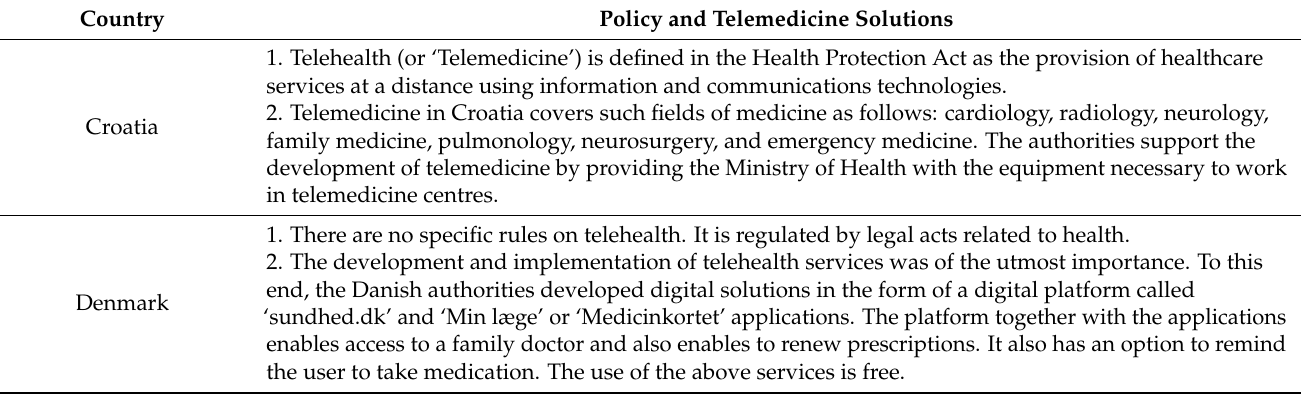
Table 1. State of legal regulations of telehealth services and examples of telemedicine solutions in selected European countries [43].